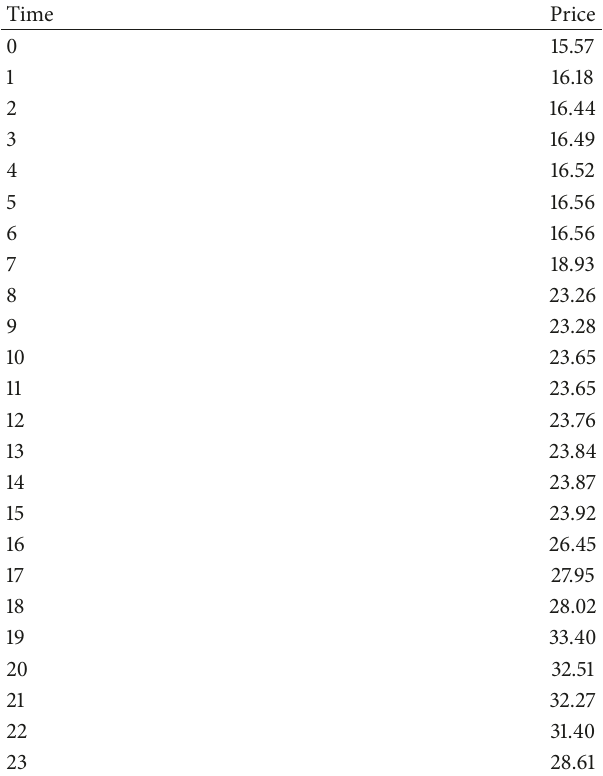
Table 2: Market real-time reserve capacity price.